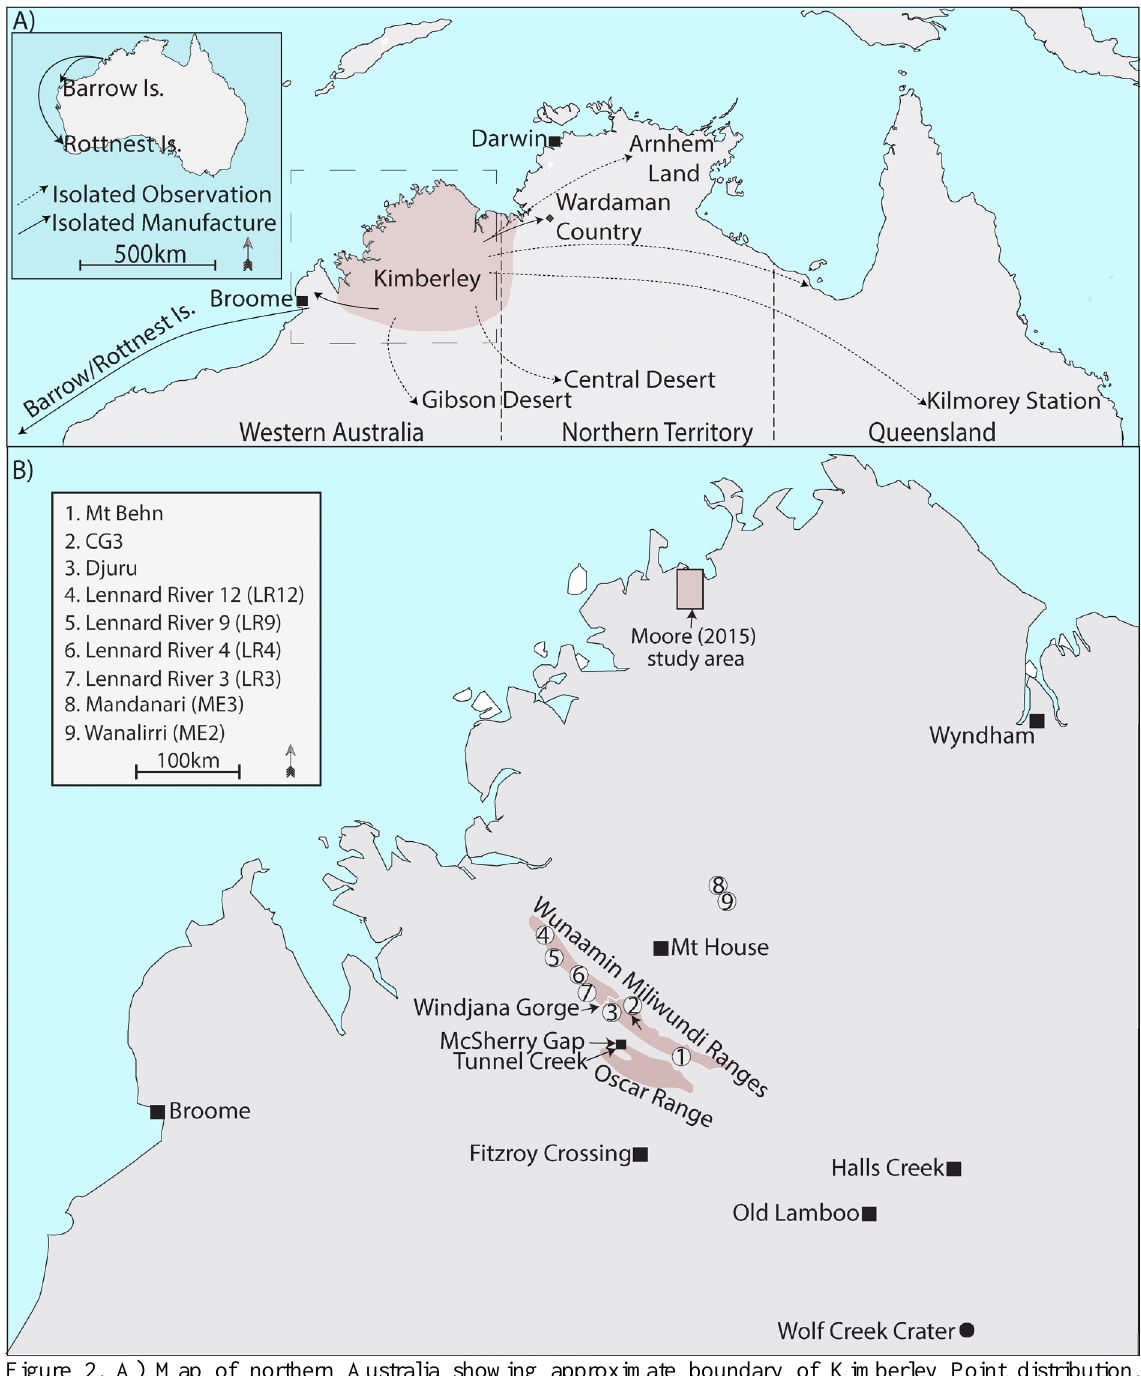
Figure 2. A) Map of northern Australia showing approximate boundary of Kimberley Point distribution, including isolated observations associated with trade (dashed line) and known manufacturing areas post contact (solid line). B) Kimberley inset showing site locations used in study and major towns and ranges associated with